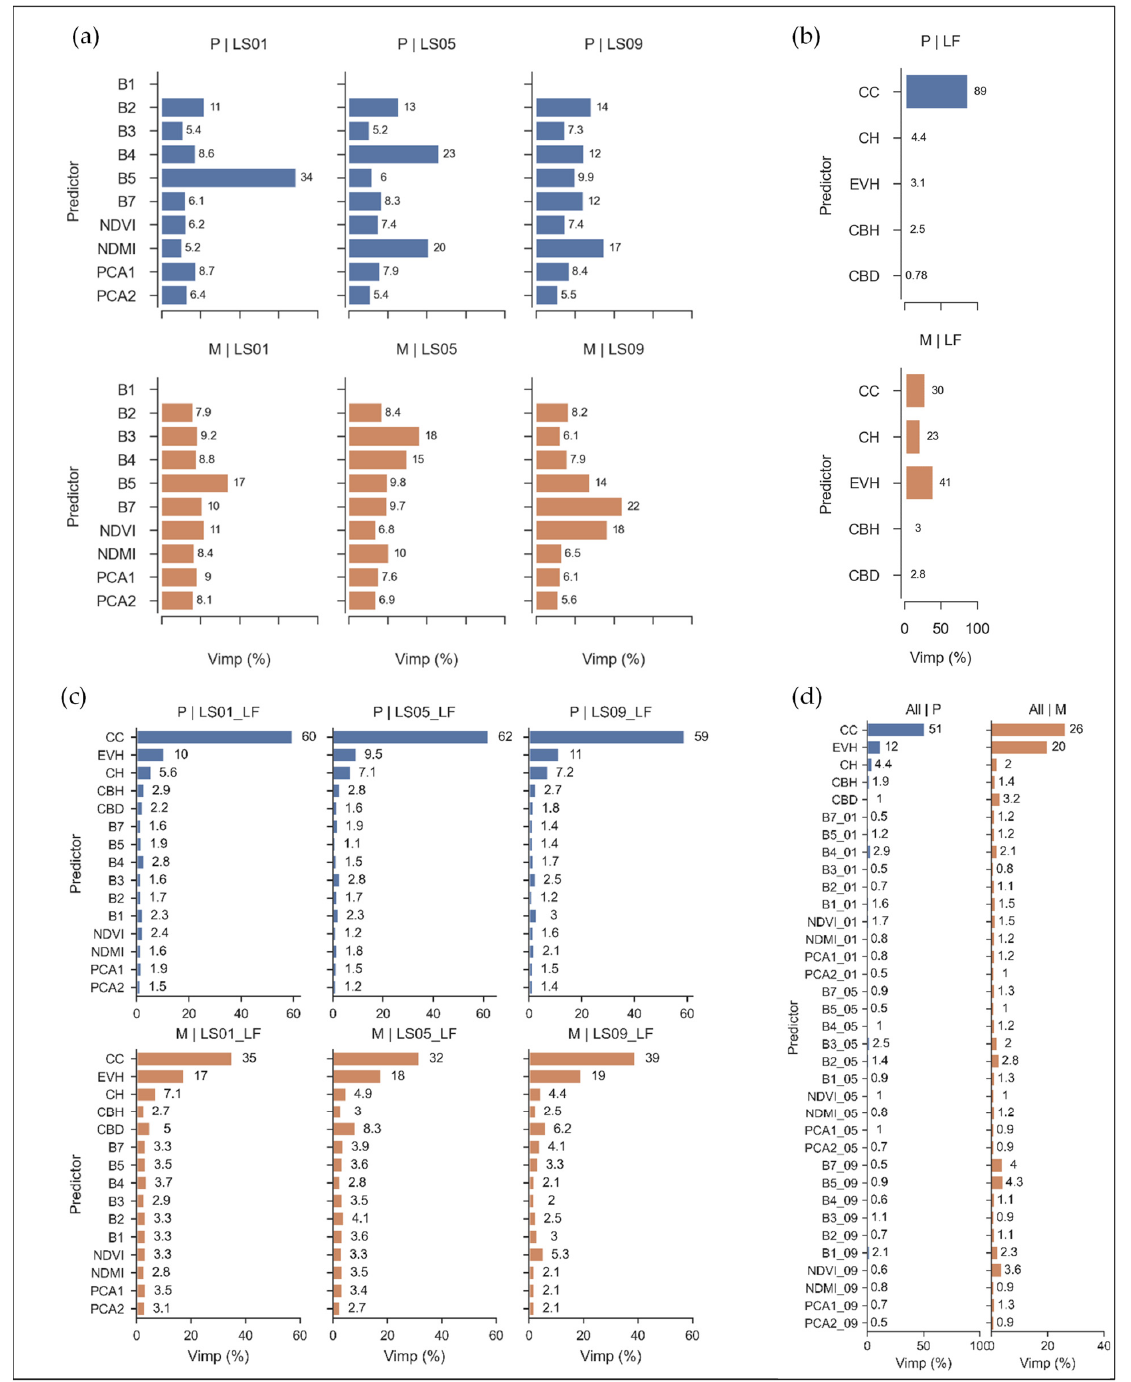
Figure 6. Percent variable importance (Vimp) for separate and combined stem volume regression mod- els: ( a ) variable importance for models fit separately with Landsat (LS01 = 01/2018, LS05 = 05/2018, LS09 = 09/2018) for pines (top row) and mixed forests (bottom row); ( b ) variable importance for mod- els fit separately with LANDFIRE (LF) data for pines (top) and mixed forests (bottom); ( c ) variable importance for models fit with LANDFIRE with each Landsat (LS01_LF, LS05_LF, LS09_LF) scene and with all the data combined (All) for pines (top row) and mixed forests (bottom row); ( d ) variable importance for models fit with all the data combined (All) for pines (left) and mixed forests (right). P denotes pines, M denotes mixed